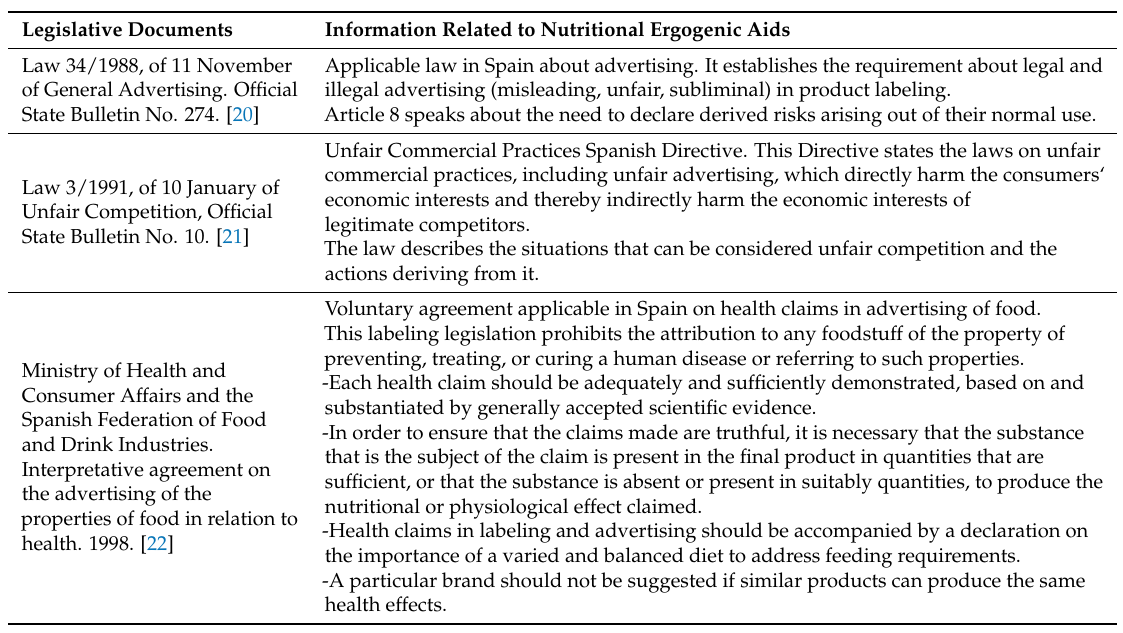
Table 1. Legislative documents on